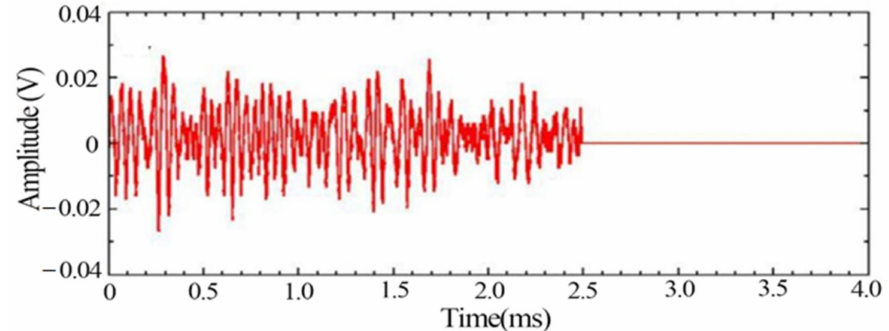
Figure 11. Waveform of noise signal.